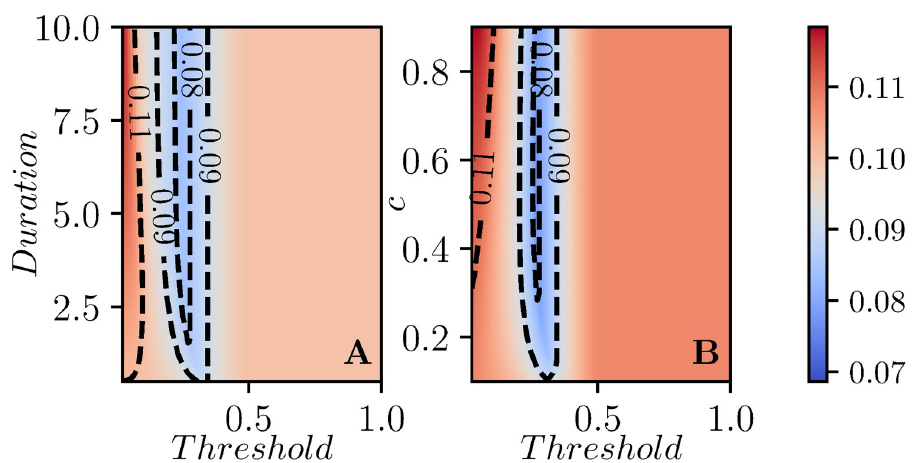
P ð t Þ during I i i 9